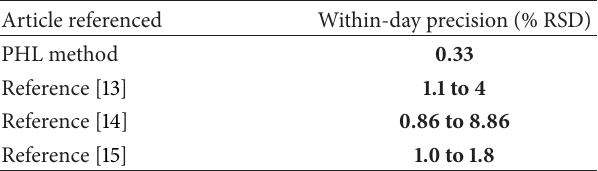
Table 4: Comparison of within-day precision values for the Wash- ingtonStateDepartmentofHealth(PHL)methodandthreeLC/MS/ MS methods referenced in this